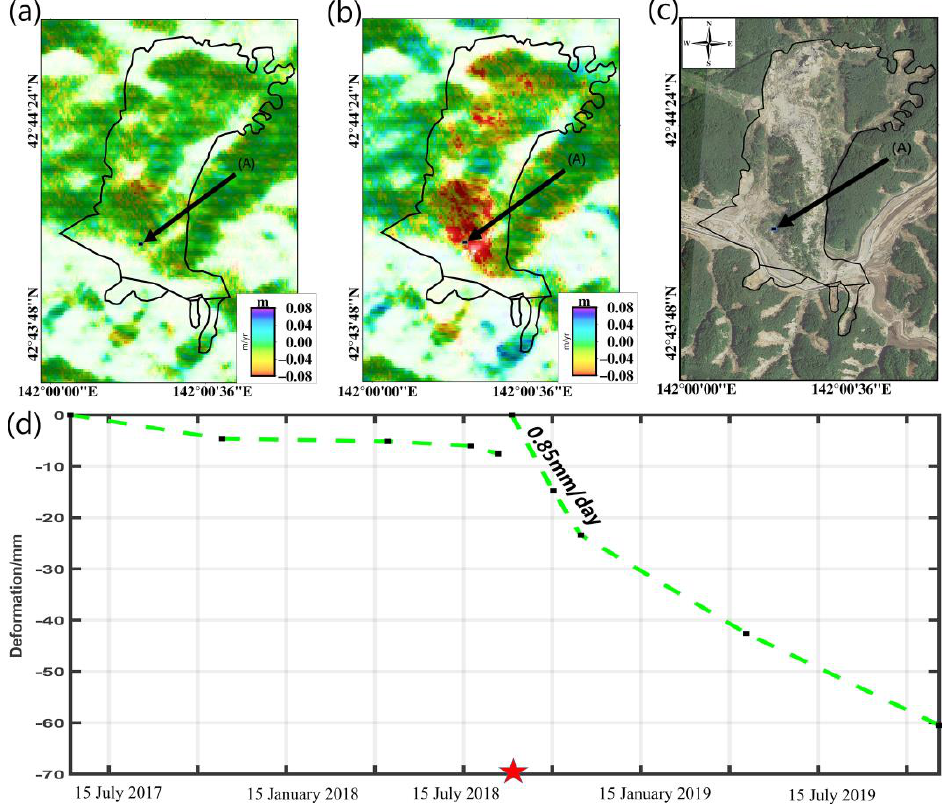
Figure 9. ( a , b ) Average LOS deformation velocities of landslide P23 before and after the earthquake, respectively. ( c ) Optical image of landslide P23 during the co-seismic period. ( d ) Time series deformation of point A before and after the earthquake. The pentagram indicates the time of the earthquake.